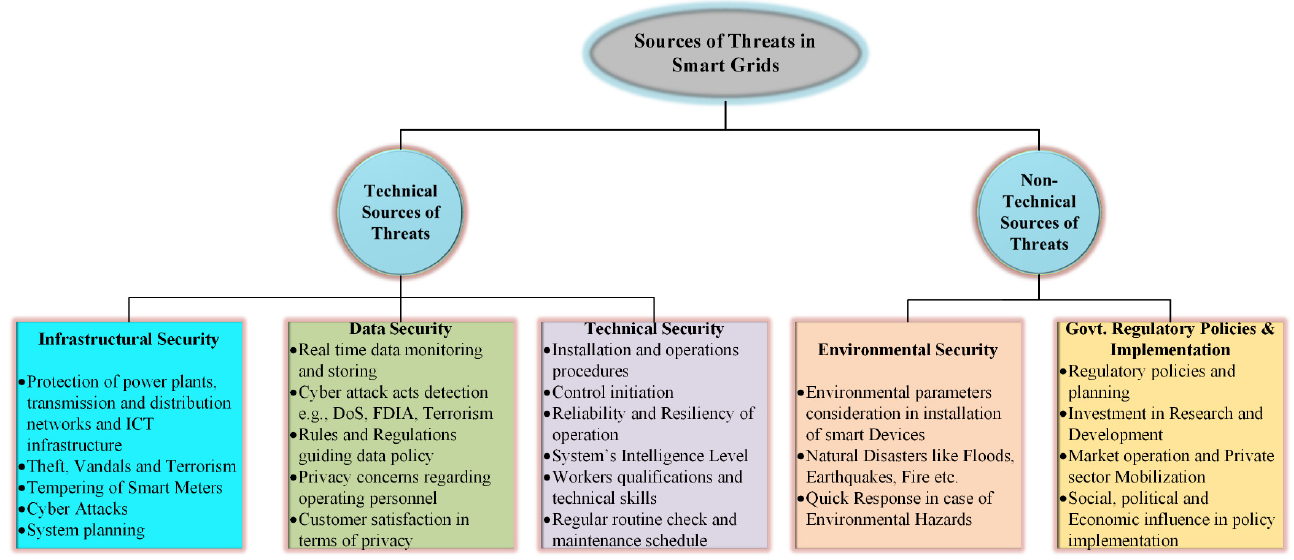
Figure 9. Classification of smart grid attacks and threats from different